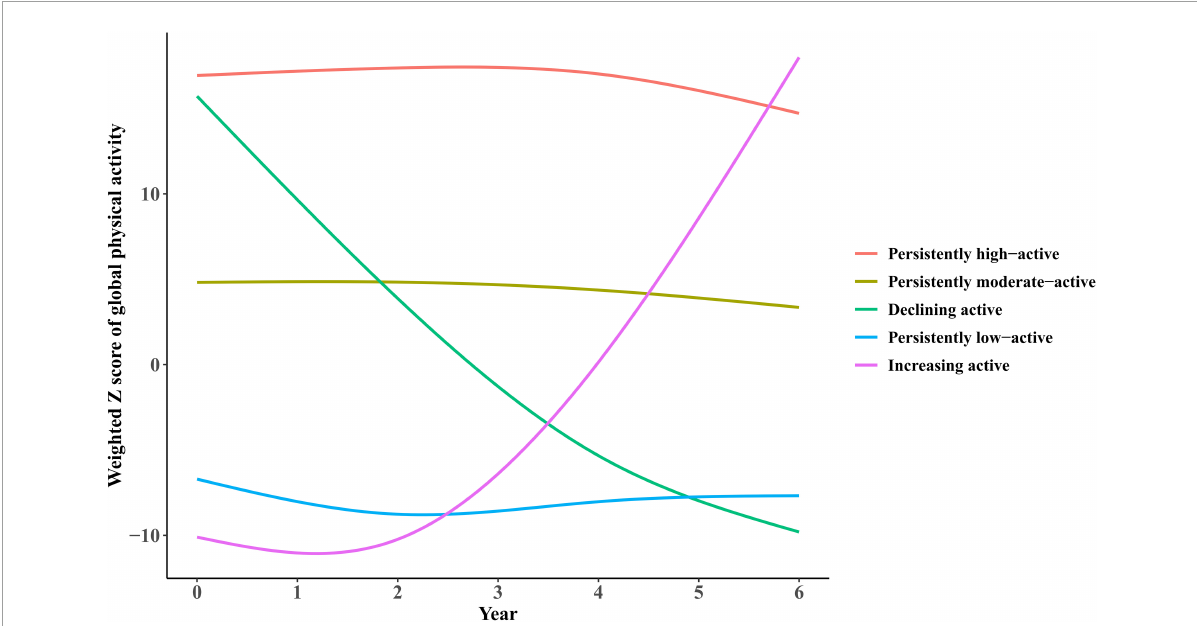
FIGURE2 Trajectories of participation in global physical activities by participants from the ELSA over a 6-year span. (1) Persistently low-active trajectory ( N = 2,039), representing low participation in physical activity (PA) during waves 1–4; (2) increasing active trajectory ( N = 1,711), representing initially low participation in PA but turned to elevating afterward; (3) declining active trajectory ( N = 216), representing high participation at early stages but turned to decreasing afterward; (4) persistently moderate-active trajectory ( N = 2,254), representing constantly moderate participation; (5) persistently high-active trajectory ( N = 2,007), representing highly participation.